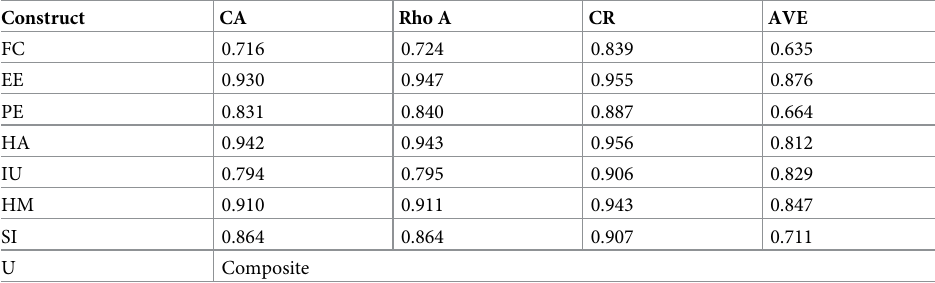
Table 4. Construct coefficients. Construct